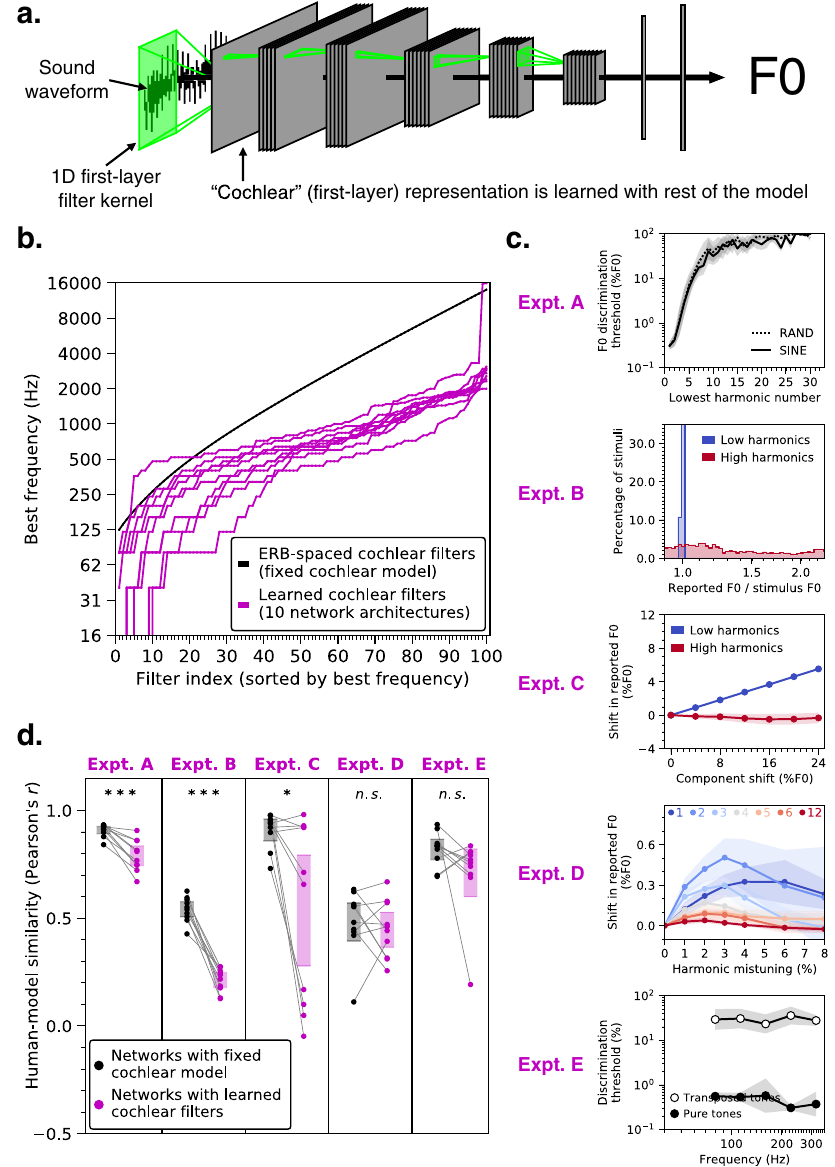
Fig. 4 Networks trained to estimate F0 directly from sound waveforms exhibit less human-like pitch behavior. a Schematic of model structure. Model architecture was identical to that depicted in Fig. 1a, except that the hardwired cochlear input representation was replaced by a layer of one-dimensional convolutional fi lters operating directly on sound waveforms. The fi rst-layer fi lter kernels were optimized for the F0 estimation task along with the rest of the network weights. We trained the ten best networks from our architecture search with these learnable fi rst-layer fi lters. b The best frequencies (sorted from lowest to highest) of the 100 learned fi lters for each of the ten network architectures are plotted in magenta. For comparison, the best frequencies of the 100 cochlear fi lters in the hardwired peripheral model are plotted in black. c Effect of learned cochlear fi lters on network behavior in all fi ve main psychophysical experiments (see Fig. 2a – e): F0 discrimination as a function of harmonic number and phase (Expt. a), pitch estimation of alternating-phase stimuli (Expt. b), pitch estimation of frequency-shifted complexes (Expt. c), pitch estimation of complexes with individually mistuned harmonics (Expt. d), and frequency discrimination with pure and transposed tones (Expt. e). Lines plot means across the ten networks; error bars plot 95% con fi dence intervals, obtained by bootstrapping across the ten networks. d Comparison of human-model similarity metrics between networks trained with either the hardwired cochlear model (black) or the learned cochlear fi lters (magenta) for each psychophysical experiment. Asterisks indicate statistical signi fi cance of two- sample t -tests comparing the two cochlear model conditions: *** p < 0.001, * p = 0.016. Error bars indicate 95% con fi dence intervals bootstrapped across the ten network experiments manipulating the fi delity of temporal coding, fol- lowed by experiments manipulating frequency selectivity along the cochlea ’ s length.